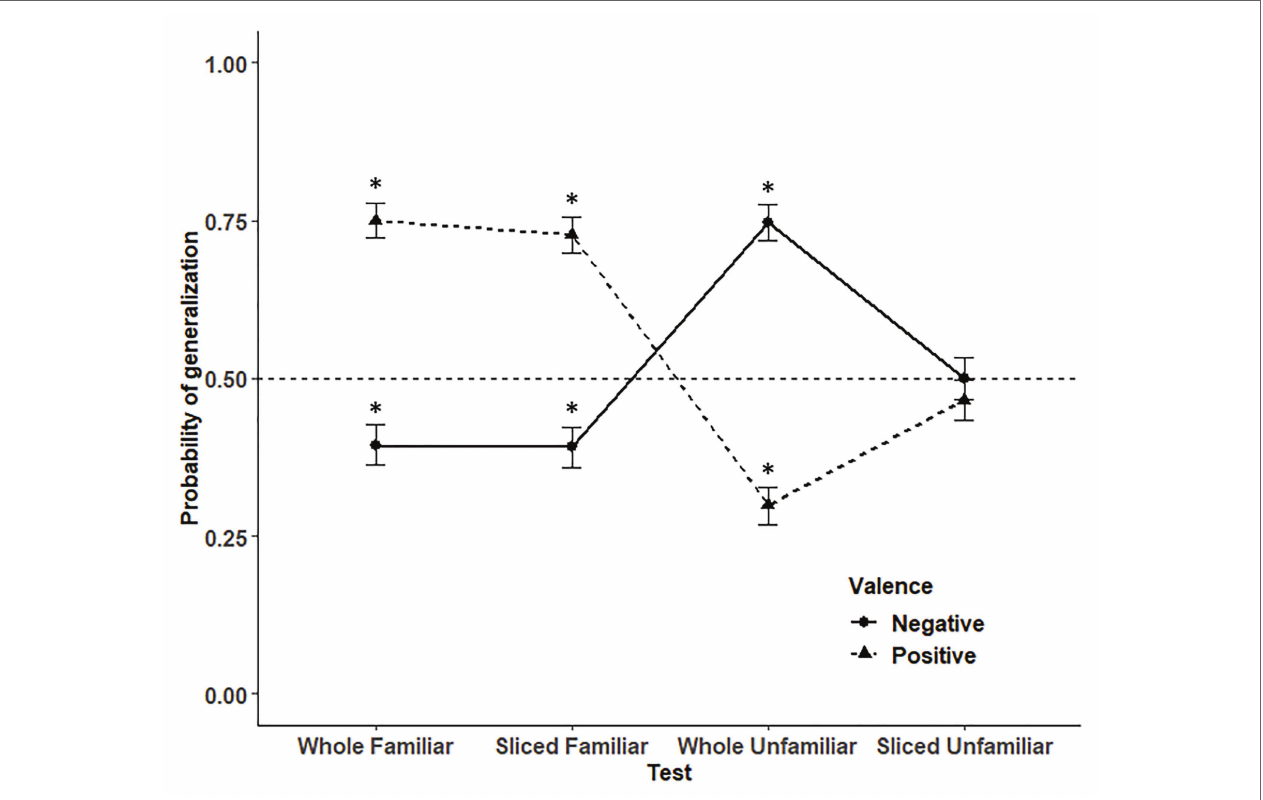
FIGURE 4 | The probability to generalize the properties as a function of Test and Valence. Stars represent significant differences against 0.5. Vertical bars represent